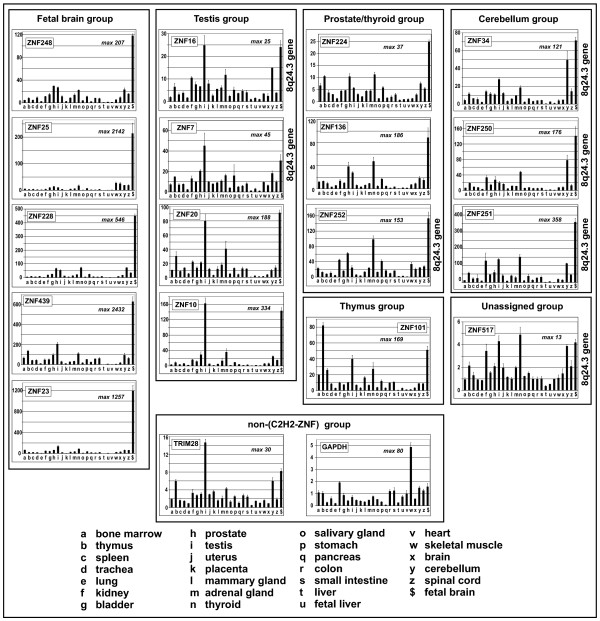
Human tissue expression profiles of the 8q24.3 ZNF genes. RNA expression profiles (labeled by gene names) of the seven 8q24.3 zinc finger genes compared to those of ten other C2H2 zinc finger genes, the KRAB domain-interacting partner TRIM28 and of the housekeeping gene GAPDH. Relative expression levels with the respective value for heart tissue set to 1 were determined with gene-specific assays by quantitative RT-PCR. The ordinate displays fold changes compared to heart. The different tissues as source for total RNA are labeled with letters and are indicated on the bottom of the bar plots. The maximal fold change between the tissue with the highest and the lowest values is indicated in the histograms ("max"). Bars represent means of three replicates ± SD within one assay. The profiles are arranged in subgroups: Strong overrepresentation in fetal brain compared to all other tissues ("fetal brain group"); values in testis similar or larger to those in fetal brain ("testis group"), prominent thyroid and prostate expression ("prostate/thyroid group"); highest expression in thymus ("thyroid group"); at least 50fold increased expression in cerebellum compared to heart and ratio fetal brain/cerebellum < 3.5 ("cerebellum group"). ZNF517 was unassigned, TRIM28 and GAPDH were put into a non-ZNF group.